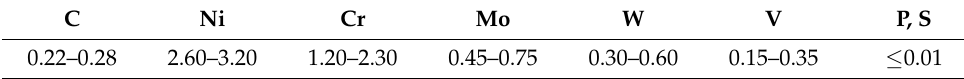
Figure 1. Schematic diagram of the cold radial forged tube. Table 1. Chemical composition of the Ni − Cr − Mo steel (wt%).